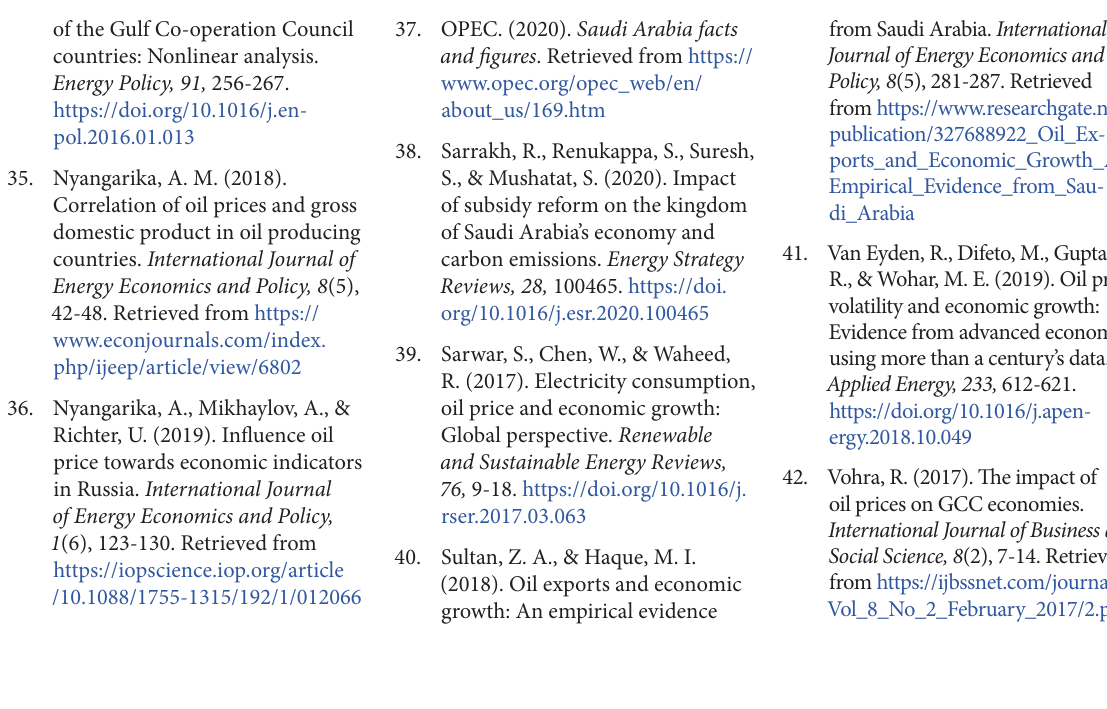
Source: Own calculations based on absolute values given in Table 1.